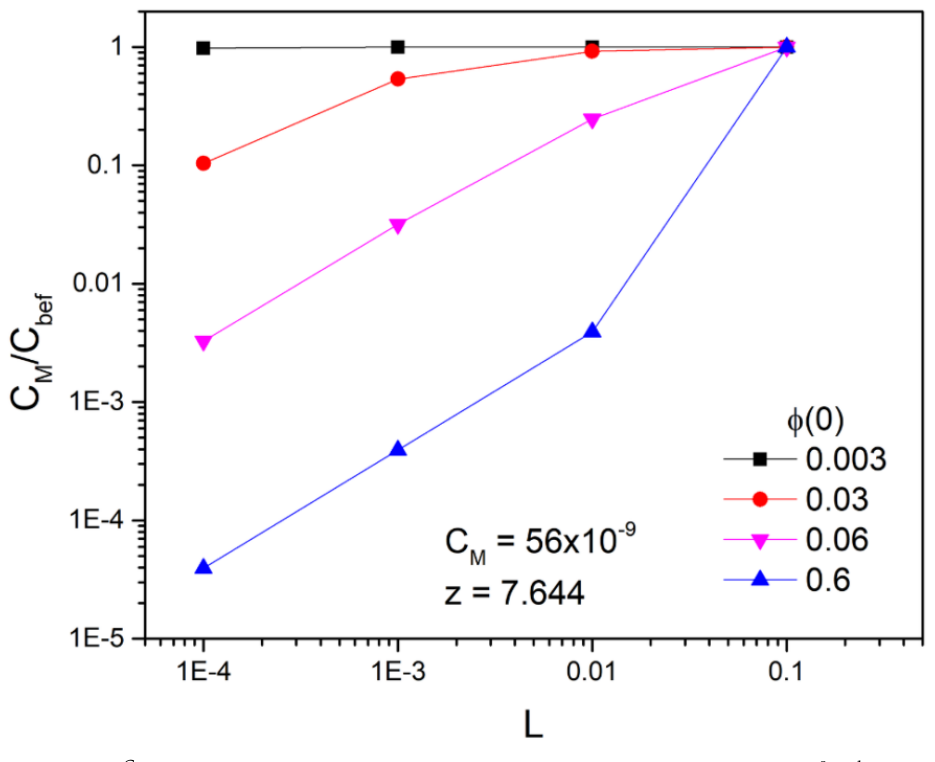
(cid:2923)(cid:2925)(cid:2922) for various for various po- m 3 (cid:2923) (cid:3119)